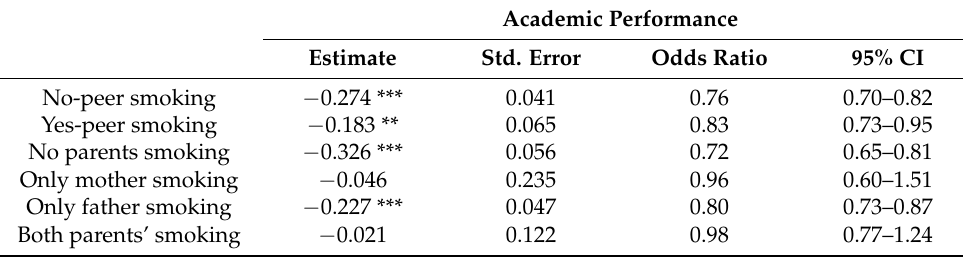
Table 3. Stratified logistic regression models stratified by peer smoking and parental smoking of academic performance on intention to smoke among non-smoking students.